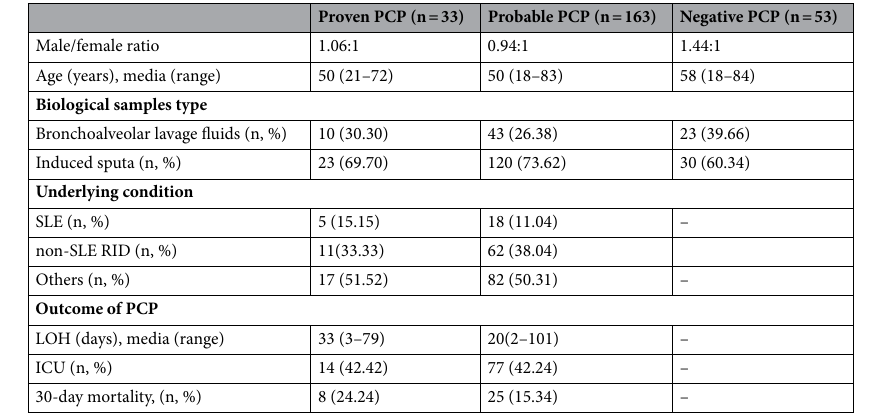
Table 2. Patient characters of LDH groups.